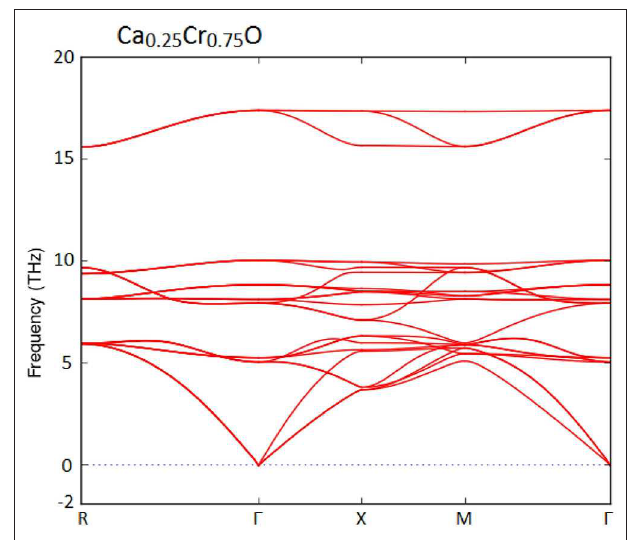
FIGURE 3 | Phonon spectra for Ca 0.25 Cr 0.75